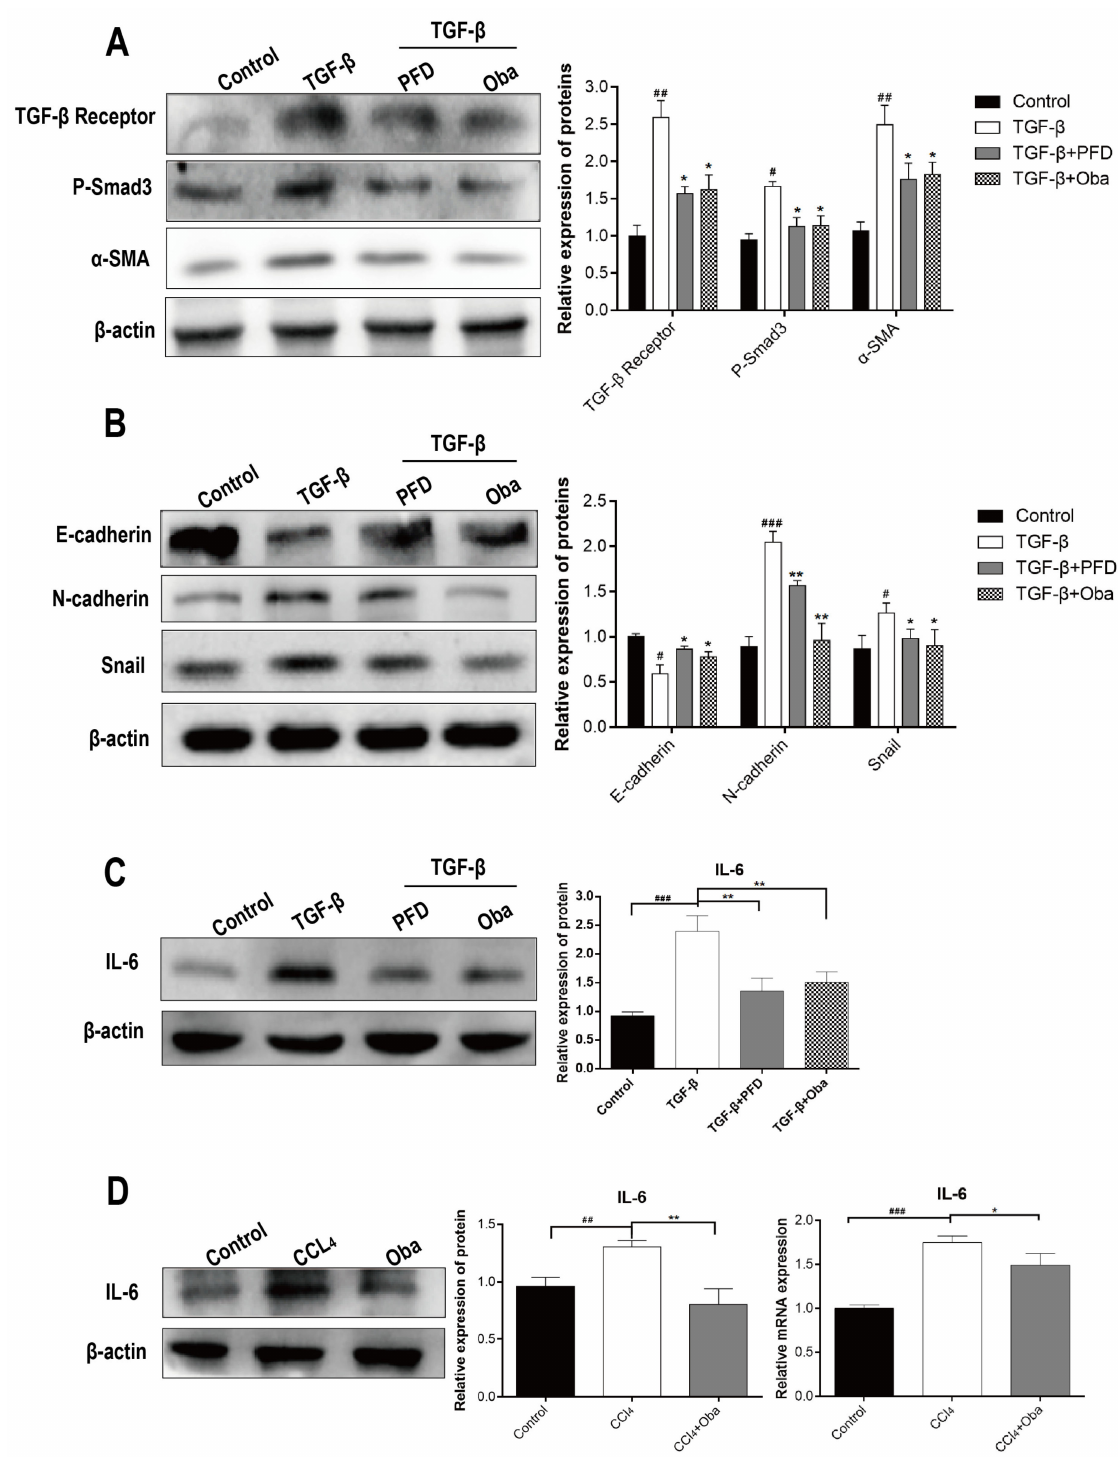
Figure 2. Oba exposure inhibited the TGF- β /SMAD/SMA signaling pathway and epithelia mesenchymal transformations (EMT) and showed anti-inflammatory effect. ( A ) Quantification of the TGF- β /Smad signaling pathway protein expression was assessed by Western blotting in vitro. ( B ) Quantification of EMT-associated protein expression as assessed by Western blotting in vitro. ( C ) Quantification of the IL-6 protein expression as assessed by Western blotting in vitro. ( D ) Quantification of the IL-6 protein and mRNA expressions as assessed by Western blotting and real-time qPCR in 20-nM CCl4-induced inflammation of Hegp-2 cells after treatment with 20- µ M Oba. The results were expressed as means ± SEM ( n ≥ 3). # , ## , ### indicate p < 0.05, p < 0.01, p < 0.001 compare with control group; ns, *, ** indicate p > 0.05, p < 0.05, p < 0.01 compare with model